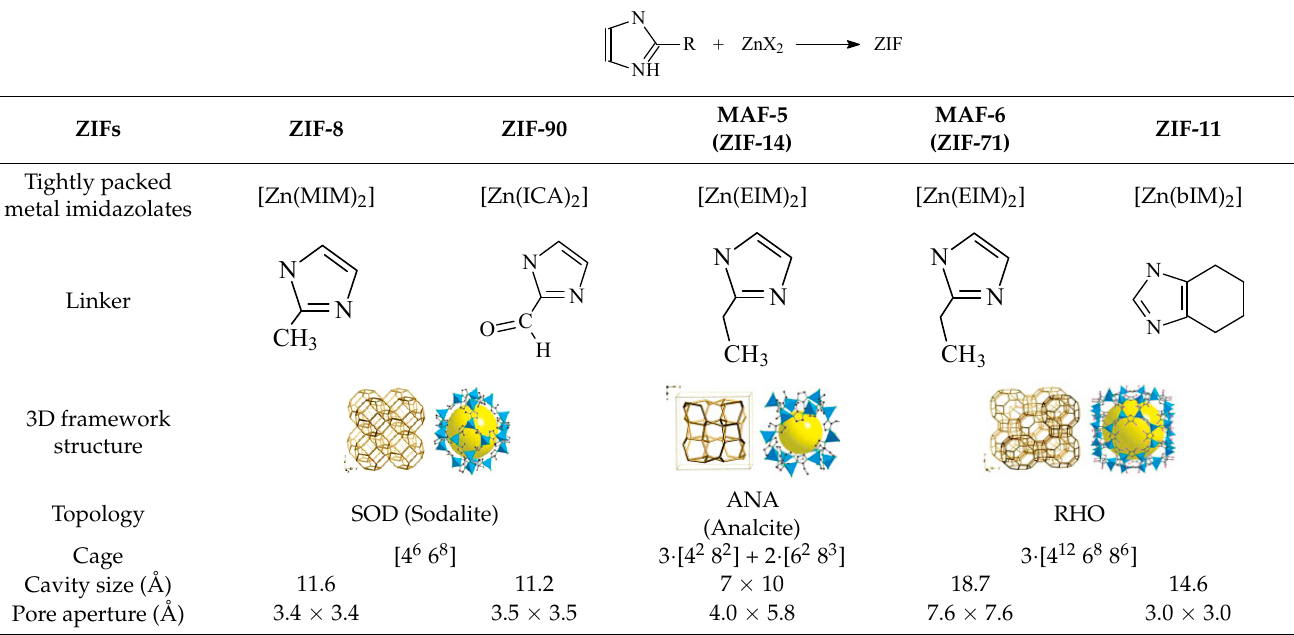
1 Table of ref. [12] was adapted with the permissions from Springer. A 3D framework of MAF ‐ 5 has analcime (ANA) zeolite topology with 4.0 × 5.8 Å apertures (Table 1) [29]. This framework is formed by cells with D3 (6 2 8 3 ) symmetry that have elongated ellipsoidal cavities (7.0 × 10.0 Å) with windows of four ‐ , six ‐ , and eight ‐ membered rings of Zn 4 (2 ‐ EIM) 4 , Zn 6 (2 ‐ EIM) 6 , and Zn 8 (2 ‐ EIM) 8 [31]. The three ‐ dimensional structures of MAF ‐ 6 and ZIF ‐ 11 have RHO topologies with large cavities (~18.7 Å) and apertures (~7.6 Å) (Table 1). The framework is formed by cells with windows of four ‐ , six ‐ , and eight ‐ membered rings containing 48 Zn atoms per unit cell [32]. Each cell is connected to six adjacent cells by polyhedral units comprising double eight ‐ membered rings.